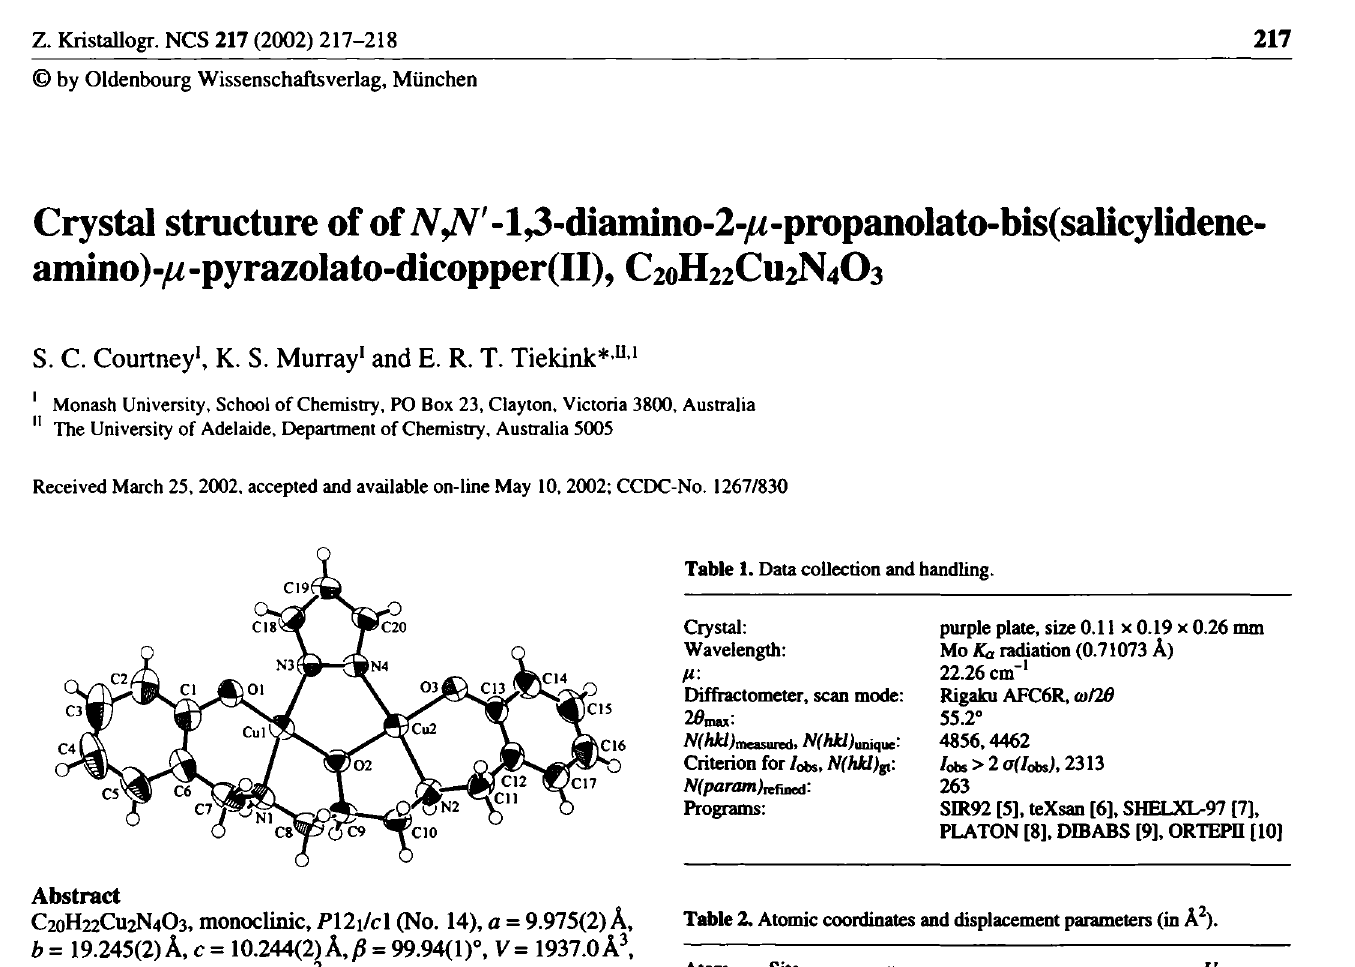
Table 2. Atomic coordinates and displacement parameters (in Â 2